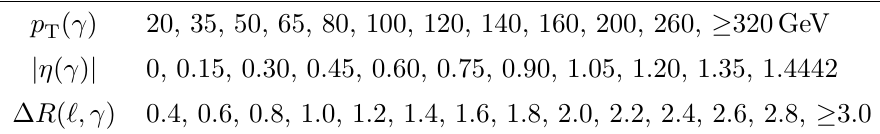
Table 7 . Binning choices in the differential measurements at the reconstruction